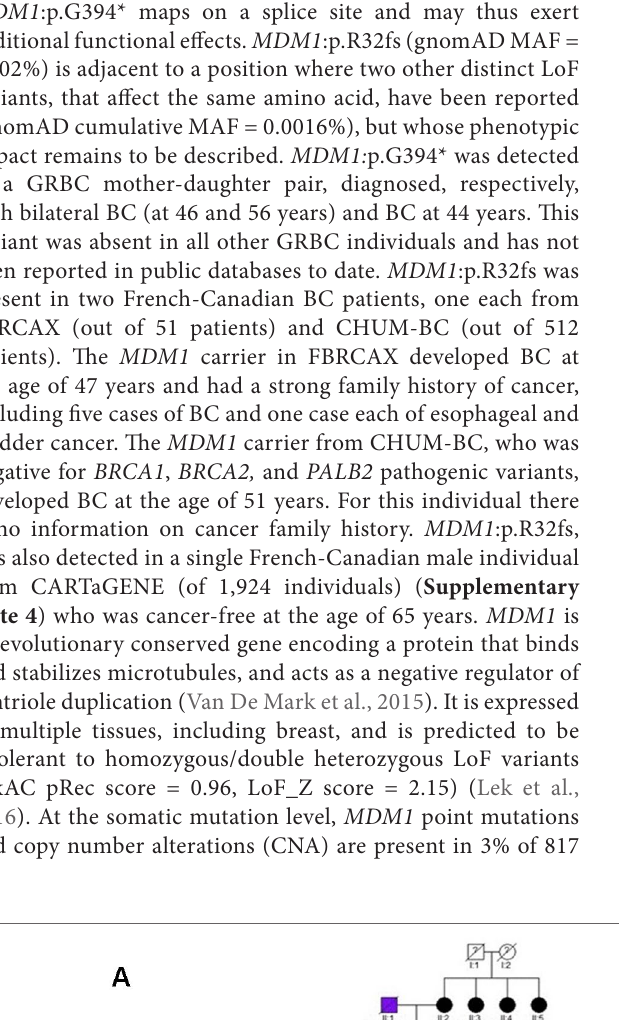
Frontiers in Genetics |